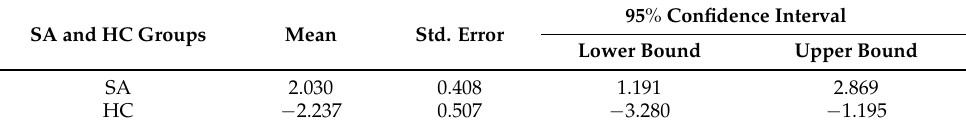
Table 8. Estimates for Groups.